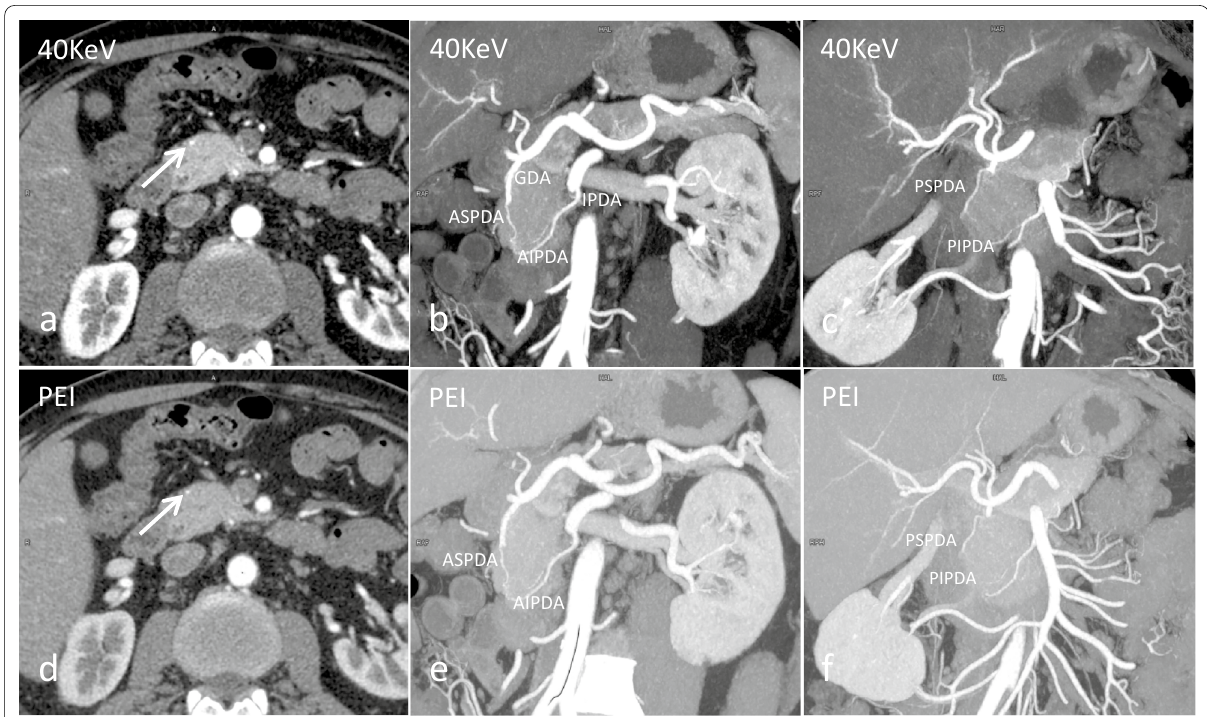
Fig. 3 The upper (a–c) and lower (d–f) rows show the 40‑keV MEI ( ) and PEI images, respectively. a The axial image shows that the anterior + superior pancreaticoduodenal artery (ASPDA) runs along the anterior and lateral surface of the pancreatic head (arrow). b Coronal reformatted image shows the ASPDA originating from gastroduodenal artery (GDA), and anastomosing inferiorly with anterior inferior pancreaticoduodenal artery (AIPDA) to form the standard anterior pancreaticoduodenal arcade. c Coronal reformatted image shows the posterior superior pancreaticoduodenal artery (PSPDA) and the posterior inferior pancreaticoduodenal artery (PIPDA). The visualization is better on the 40‑keV MEI ( compared to the